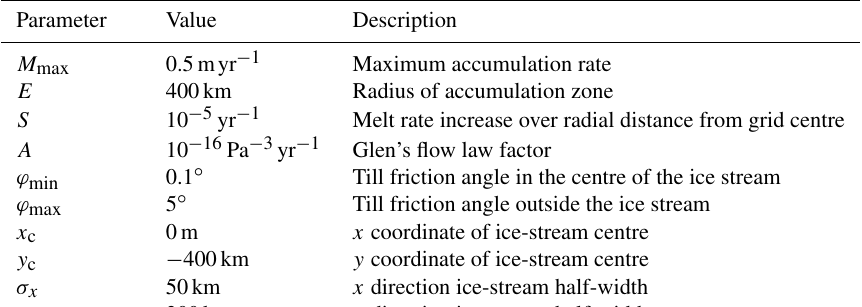
Table 1. Parameter values for experiment I.